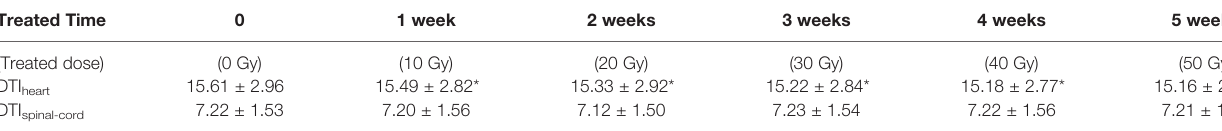
TABLE 4 | DTI changes under different radiation doses